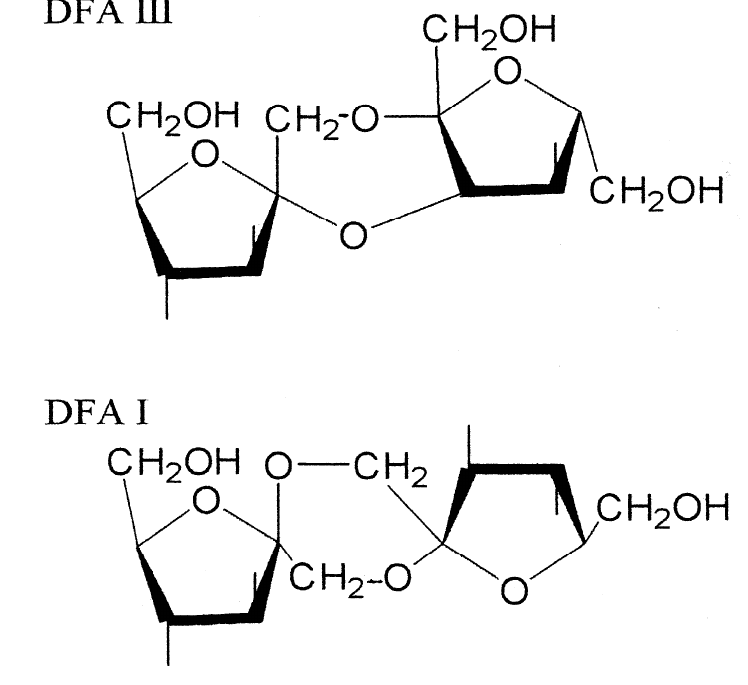
Figure 1. The chemical structures of oligosaccharides DFA III and DFA